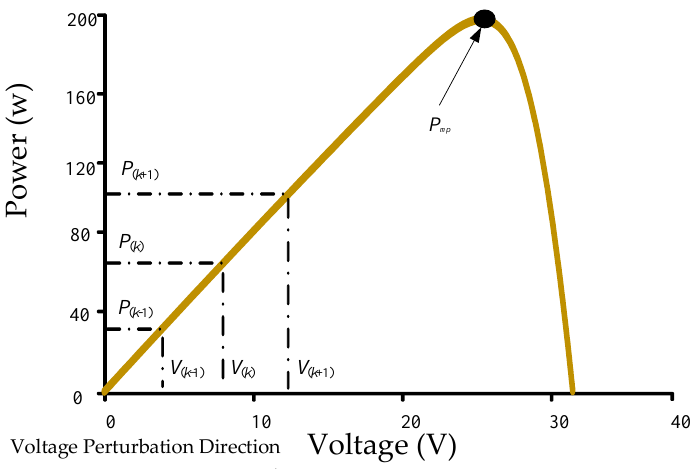
Figure 1. Work illustration for positive perturbation voltage of the perturbation and observation method.